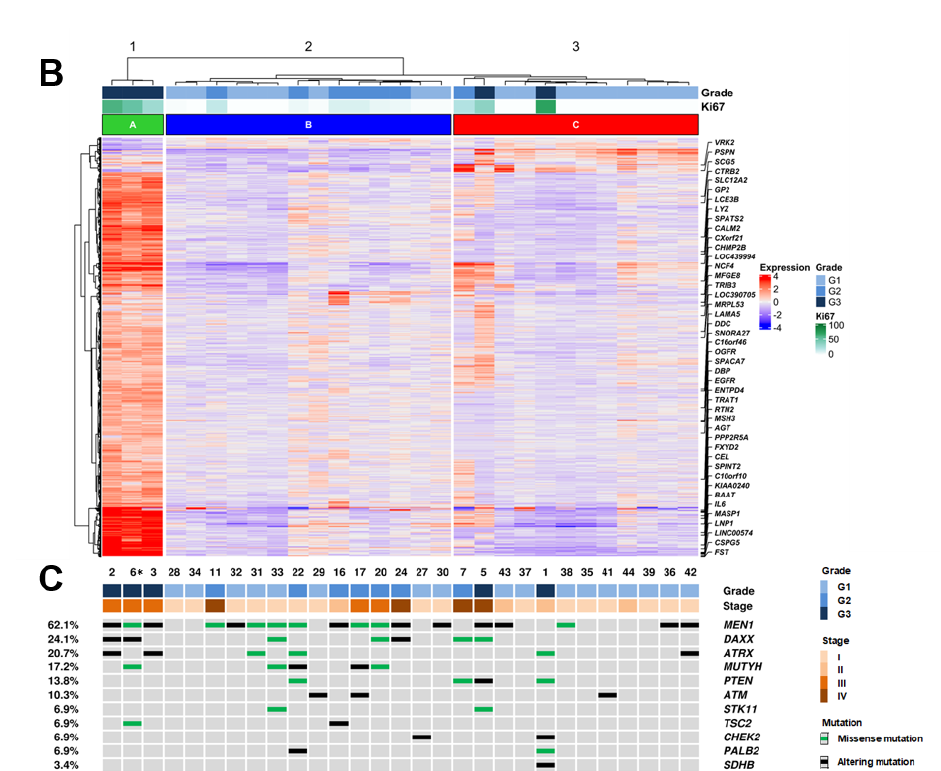
Figure 1. Integrated RNA and DNA sequencing of 29 PanNET samples (28 primary and one metachronous G3 recurrency *) grouped by histological grade. ( A ) Overlap of differentially expressed genes in G3 vs. G2, G3 vs. G1 and G2 vs. G1 PanNETs. ( B ) Hierarchical clustering of RNA gene expression and Deseq2 approach defined 3050 genes as significantly differentially expressed between histological grades. ( C ) List of 11 genes that were altered at sequencing analysis; the legend for alteration type is reported in the panel on the right. * (Patient ID #6, Supplementary Table S1).